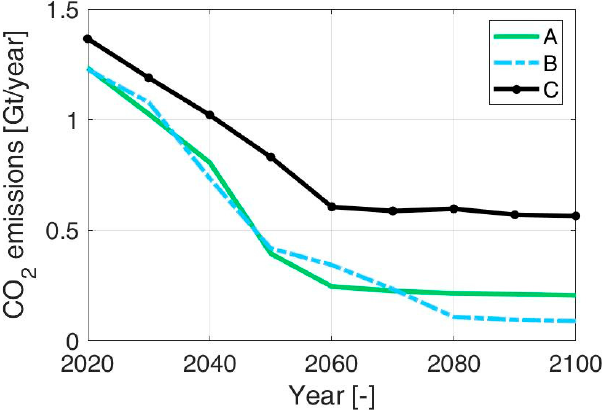
Figure 12. CO (cid:2870) emissions from the road transport sector. Figure 12. CO 2 emissions from the road transport sector.